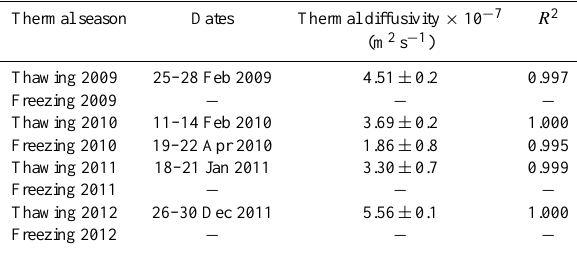
Table 10. Thermal diffusivity calculated by exponential fitting of thermal amplitude in a selected period of time in which ground temperatures at 2.5, 5, 10 and 20cm depth show a well-defined si- nusoidal